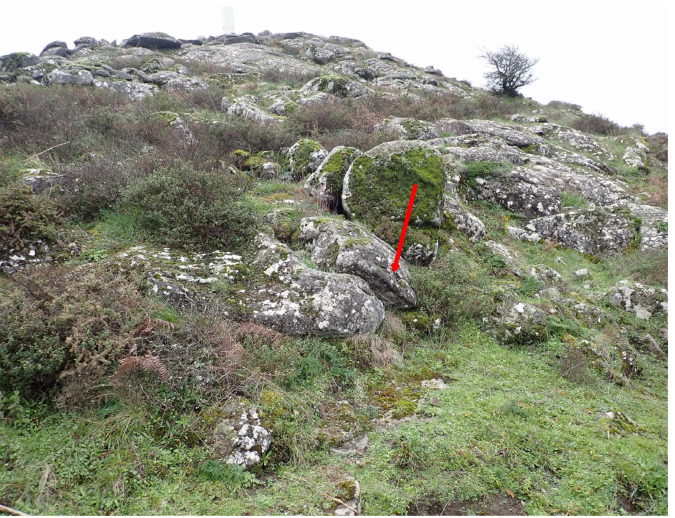
Figure 6. North-facing syenite rock outcrops on the summit of F ó ia, Serra de Monchique, type locality of Marsupella lusitanica , one of the micropopulations (paratype 3) arrowed. Photo by R.D. Porley, 19 January